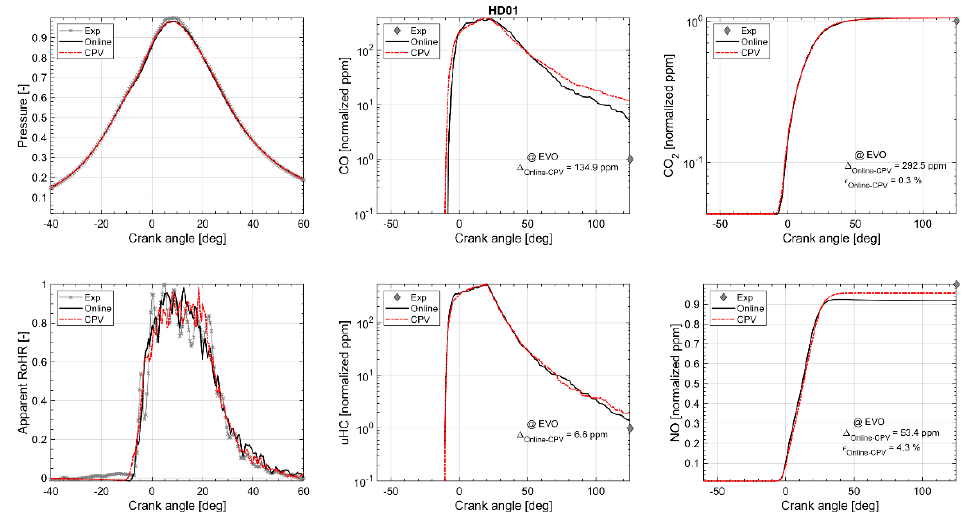
Figure A1. Engine performance and emissions for operating point HD01 (1700 rpm, 19.0 bar IMEP).